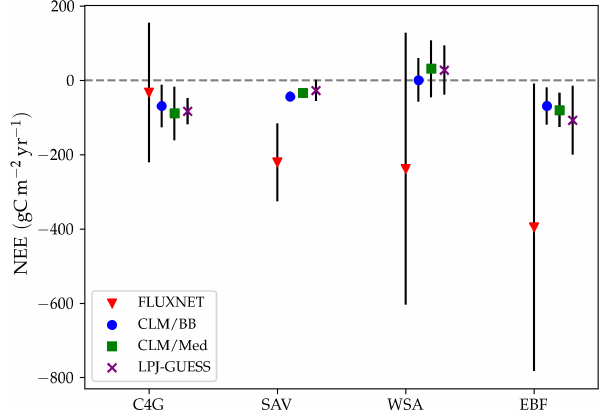
Figure 9. Comparison between observed and modelled annual NEE. The symbols indicate averages over sites with the same land cover type. Red triangles correspond to flux tower CO 2 measure- ments. Blue dots, green squares, and purple crosses correspond, re- spectively, to the CLM/BB, CLM/Med, and standard LPJ-GUESS simulations. The bars represent 1 standard deviation above and be- low the